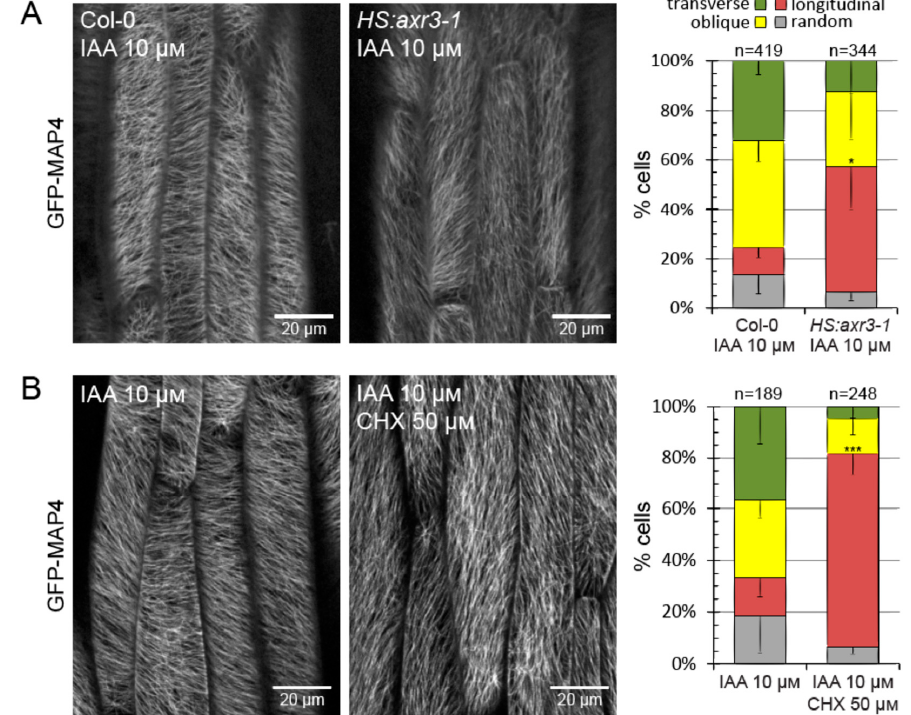
Figure 3. Cortical microtubule array reorientation by auxin is mediated by the SCF TIR1 / AFB -Aux / IAA-ARF nuclear signaling pathway. The inhibition of nuclear auxin signaling by the conditional expression of a dominant-negative mutant of the Aux / IAA protein AXR3 / IAA17 ( HS:axr3-1 ) ( A ) or by blocking protein translation with cycloheximide (CHX, 50 µ M) ( B ) prevented the auxin-induced reorientation of cortical microtubules. The GFP fluorescence is depicted in grayscale. The graphs show the average percentage of cells in each category from three experiments. Error bars indicate standard deviation (only the lower bar is shown for clarity). Total cell numbers are given above each graph. The frequencies of cells with longitudinal arrays were compared using t tests, p = 0.0176 (*) in A and p = 0.0007 (***) in B